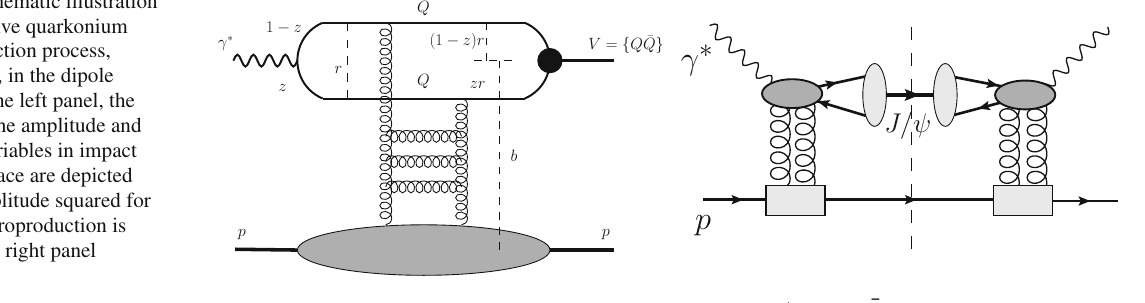
Fig. 1 A schematic illustration of the exclusive quarkonium electroproduction process, γ ∗ p → V p , in the dipole picture. On the left panel, the structure of the amplitude and kinematic variables in impact parameter space are depicted while its amplitude squared for the J /ψ electroproduction is shown on the right panel